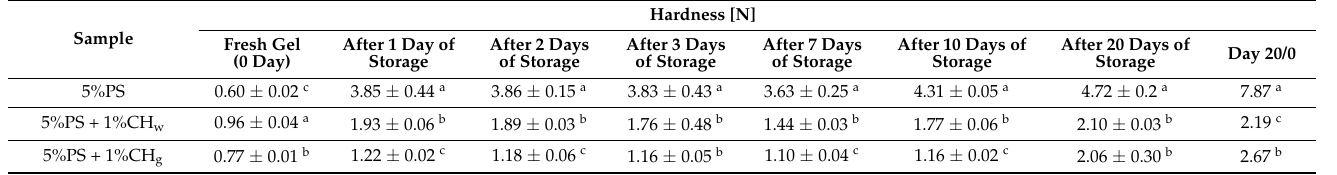
Table 5. Gel hardness (N) of 5% PS and its mixtures with 1% CH (whole and ground) measured as fresh gels and gels stored for 20 days at 4 ◦